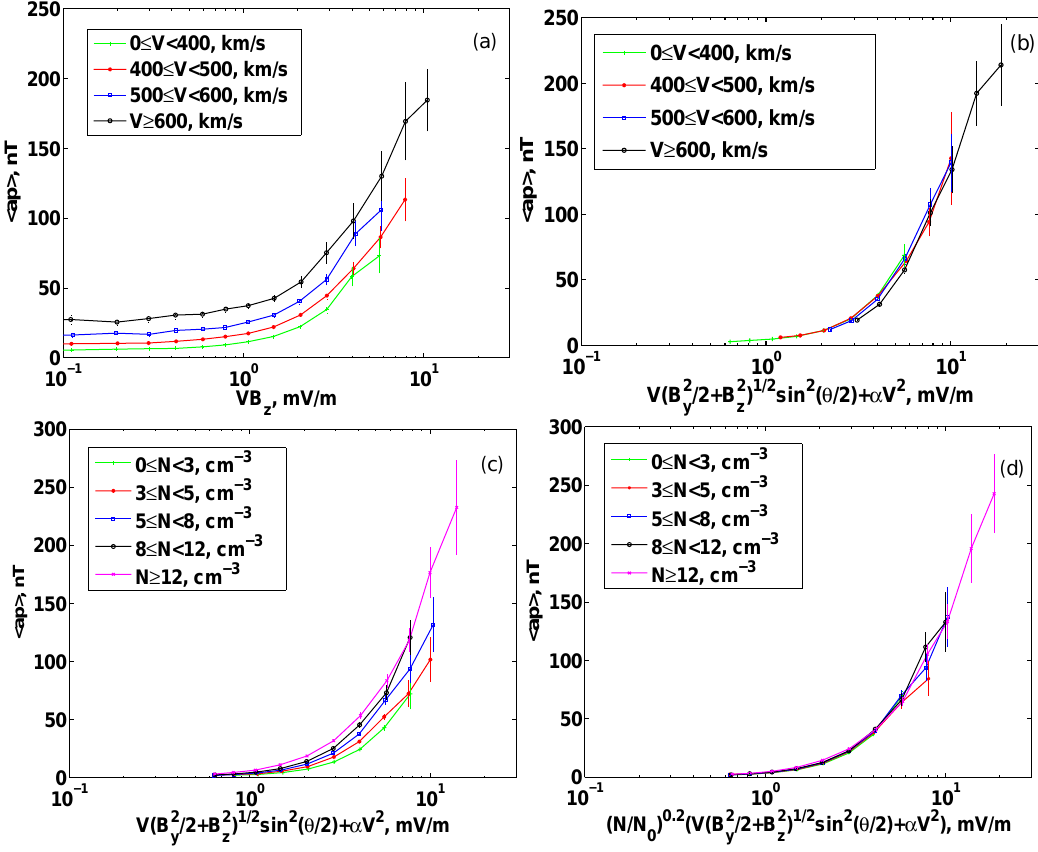
Fig. 2. Solar wind speed and density input to a p . Thin vertical lines denote 90%-significance range of mean values. The averages from bins with less than 10 data points are not plotted.